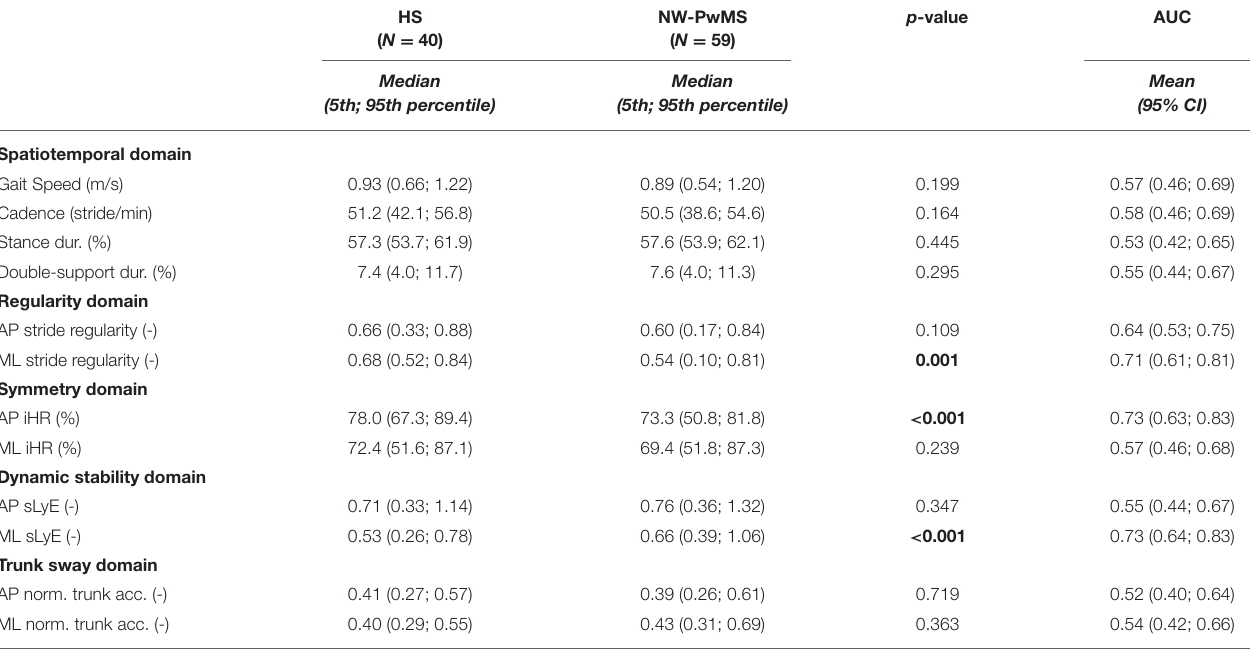
TABLE 4 | Instrumented metrics describing walking with horizontal head turns in healthy subjects and normal-walking people with